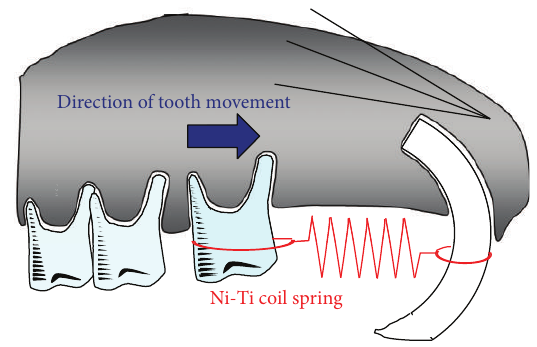
Figure 1: Schema of appliance for orthodontic tooth movement in mice. The orthodontic appliance is composed of a Ni-Ti coil spring. Theappliancewasinsertedbetweentheupperincisorsandtheupper left first molar and fixed with a 0.1 mm stainless wire around both